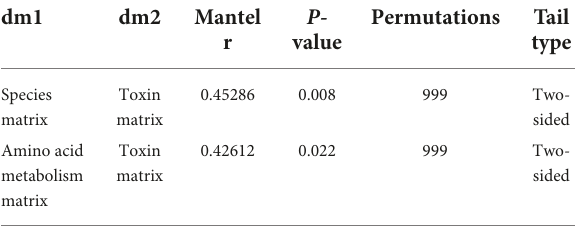
TABLE 1 Correlation of mantel test in